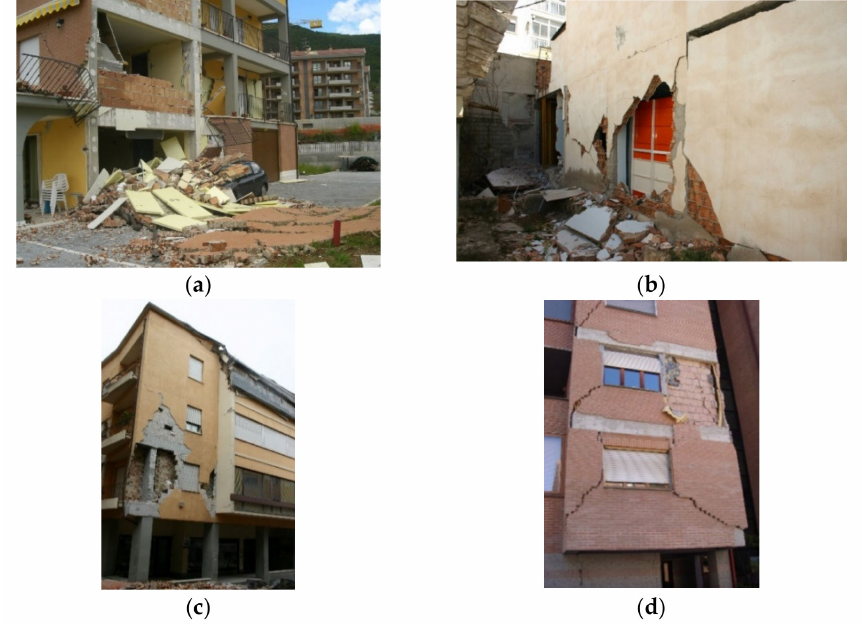
Figure 22. Damage type 10—damage in infill panels: OOP collapse in low-medium RC structures: ( a ) L’Aquila, Italy, 2009; ( b ) Lorca, Spain, 2011; ( c ) L’Aquila, Italy, 2009 and ( d ) L’Aquila, Italy,